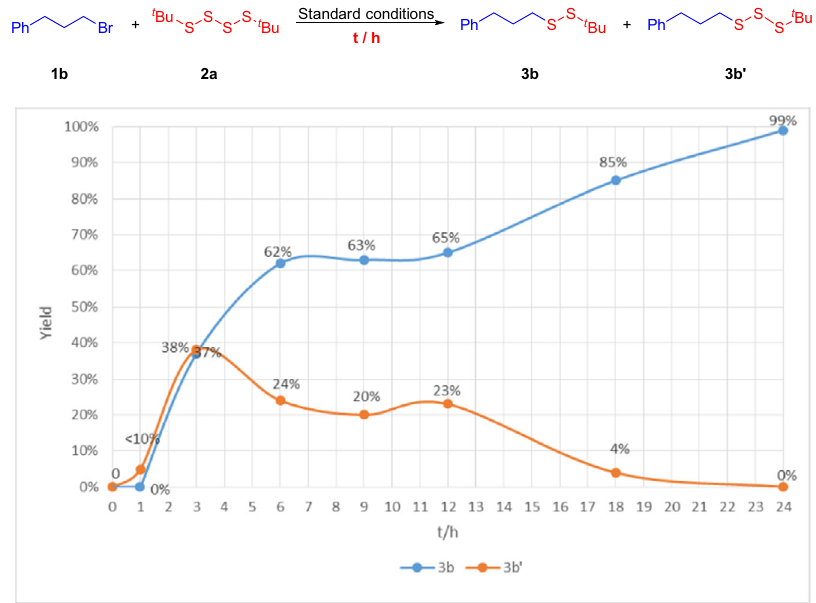
Fig. 6 Investigation of the reaction process. The investigation of the template reaction under standard conditions at different time by GC-Ms.